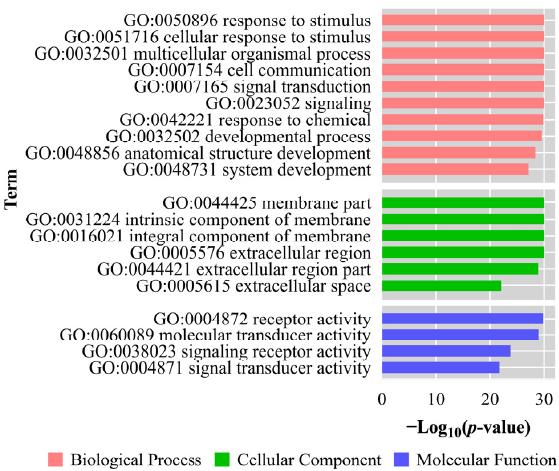
Figure 6. GO classification of DEGs after B. cereus infection. The top 20 terms of the three GO taxonomies, biological processes, cellular components, and molecular function, are